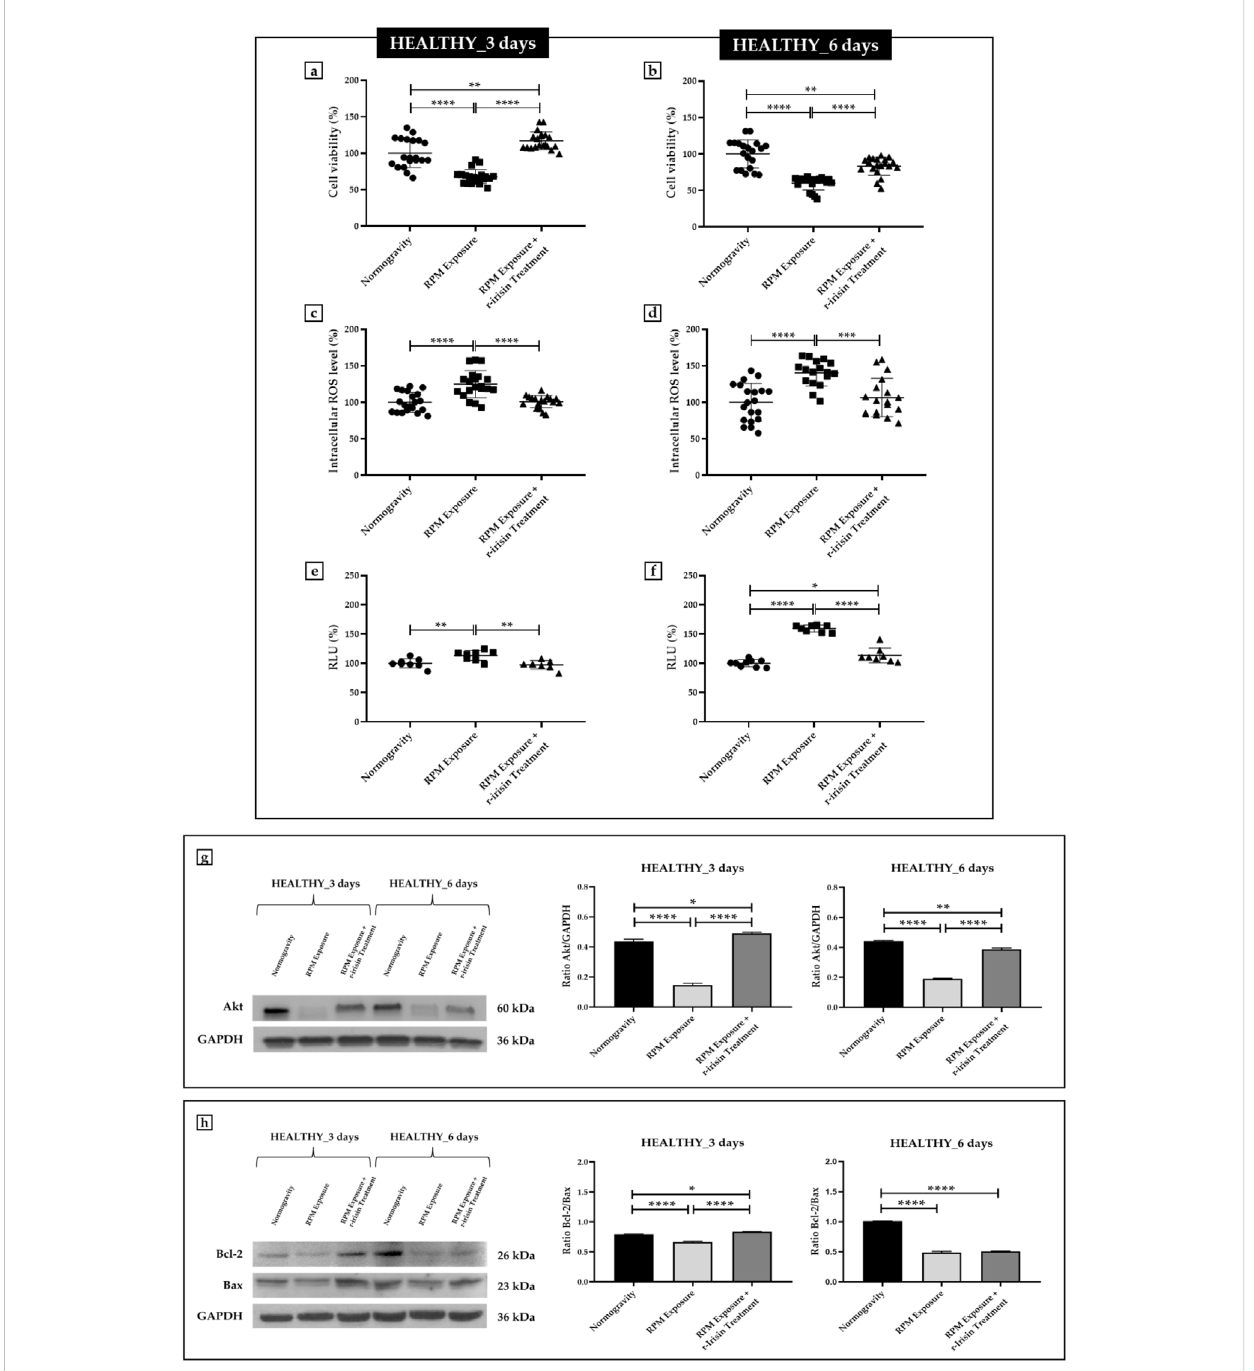
FIGURE 1 Effectsofrandompositioningmachine(RPM)exposureonthesurvivalofprimaryosteoblastculturesderivedfromhealthy(HEALTHY)subjects. (a,b) MTS assay: cell viability was completely (a) or partially (b) preserved in cells treated with r-irisin and exposed to RPM. (c,d) Intracellular levels of reactive oxygenspecies(ROS):theincreaseinoxidativestressinducedbyexposuretoRPMwascounteractedbyr-irisintreatment. (e,f) Caspase-3/7activity:total (e) orpartial (f) prevention ofcaspase activity induced by RPM exposure inr-irisin-treatedcells. (g) Westernblotting analysis for Akt/protein kinase B (PKB): r-irisin treatment fully (3 days) or partially (6 days) preserved Akt expression. (h) Western blotting analysis for B-cell lymphoma 2 (Bcl-2) and Bax: signi fi cant increase in the Bcl-2/Bax ratio after r-irisin treatment (3 days); alteration of the Bcl-2/Bax ratio after 6 days of RPM exposure and r-irisin treatment, in favor of